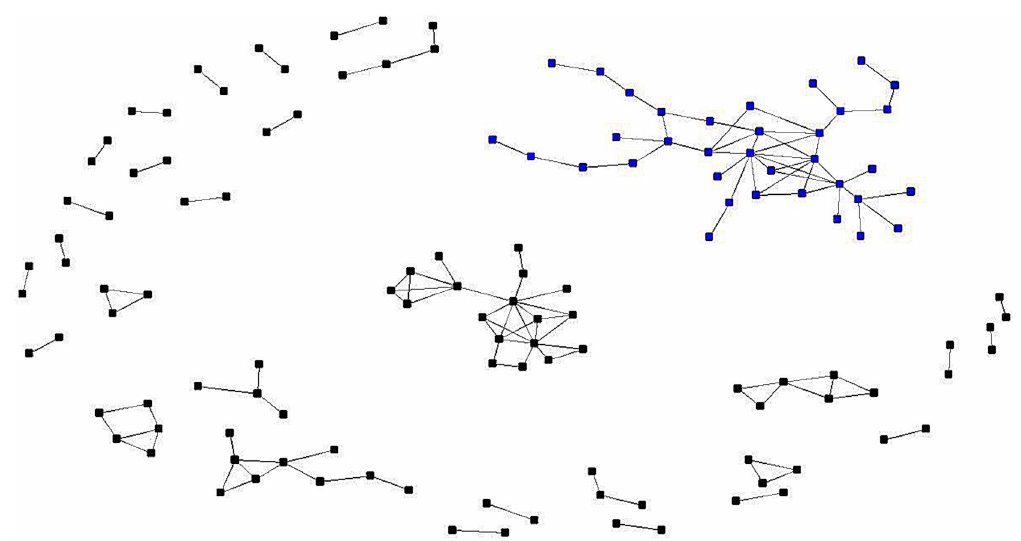
Figure 2. The collaboration network of Romanian sociologists. The largest fully connected component is marked blue. It can be observed that the network is very fragmented, with many pairs, open and closed triplets being completely isolated from each other.